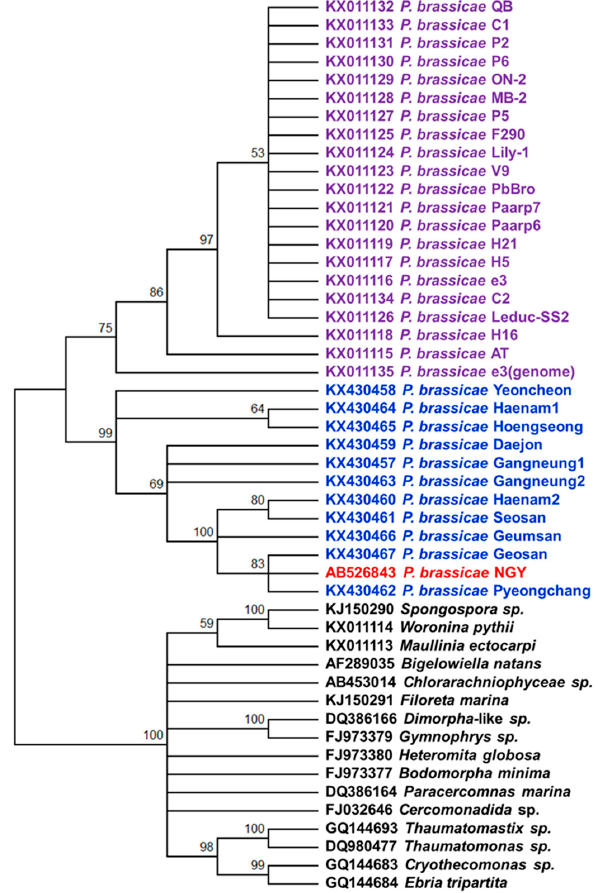
Figure 6. Phylogenetic tree constructed following the Maximum Likelihood method and Jukes-Cantor model in Mega6.06 software between the 11 Korean field isolates and the reference isolates of P. brassicae , based on variations in the nucleotide sequences of rDNA. Complete rDNA, if available, or LSU sequences were used. Accessions with “KX4304” were obtained in this study. Purple, red and blue colours indicate P. brassicae rDNA sequences obtained from Schwelm et al. [32], Niwa et al. [31] and this study. Black colours indicate rDNA sequences from other cercozoa species.